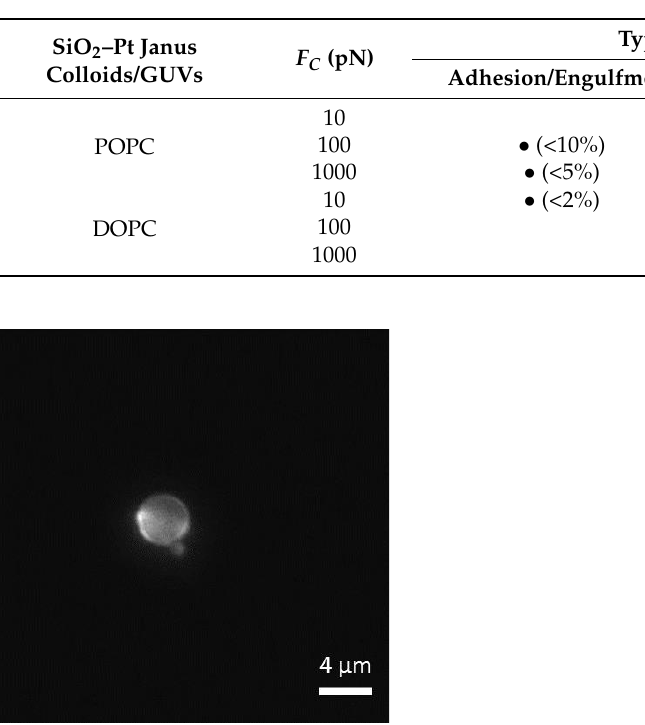
Table 2. Effect of centrifugal force on POPC and DOPC GUVs interacting with SiO 2 – Pt Janus colloids, where (●) signifies a significant number of observed events.